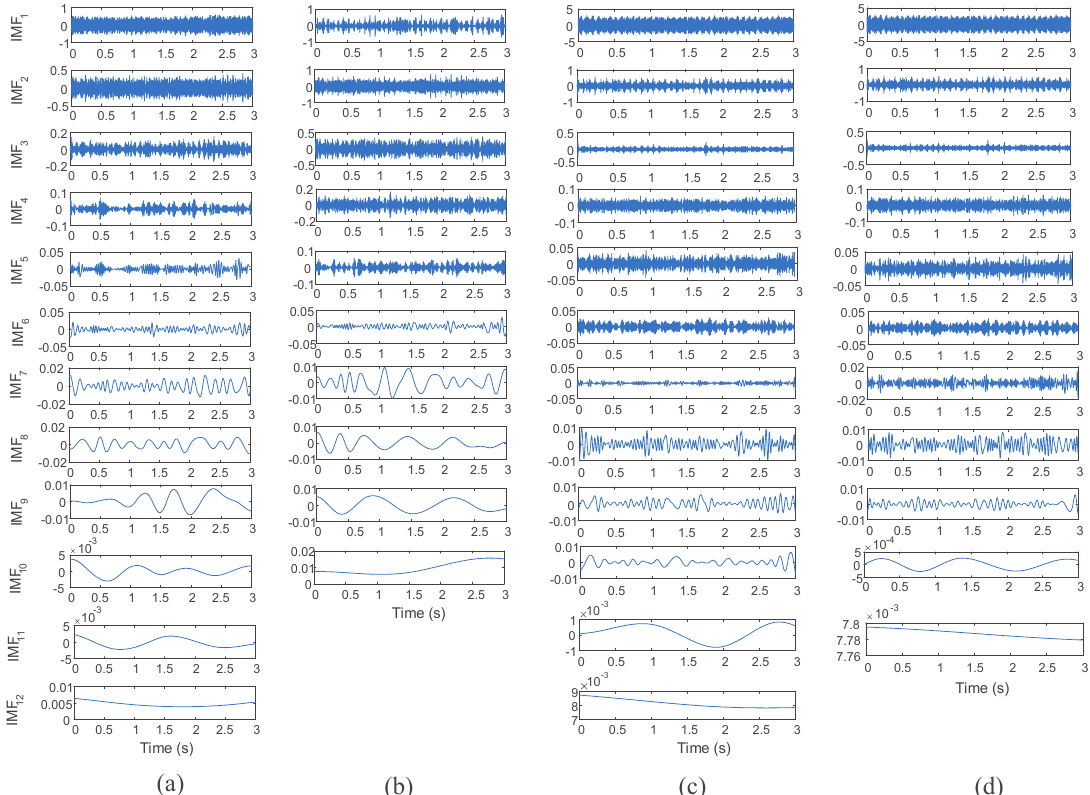
Figure 6. Decomposition results of ICEEMDAN. ( a ) the vibration signal under normal state are decomposed by ICEEMDAN; ( b ) the vibration signal under slight wear are decomposed by ICEEMDAN; ( c ) the vibration signal under moderate wear are decomposed by ICEEMDAN; ( d ) the vibration signal under severe wear are decomposed by ICEEMDAN. Then, the appropriate IMF component is selected by using the correlation coefficient method